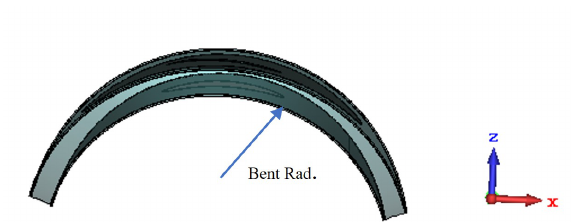
Figure 7. The antenna topology under